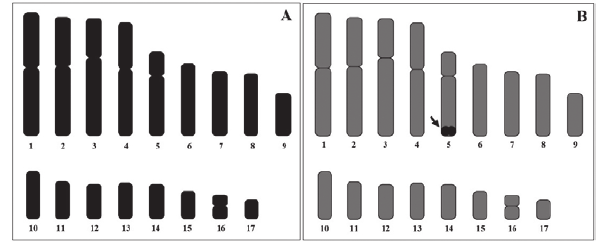
Figure 4. Idiogram represents chromosome type, size, and Ag-NOR banding of G. nutaphandi